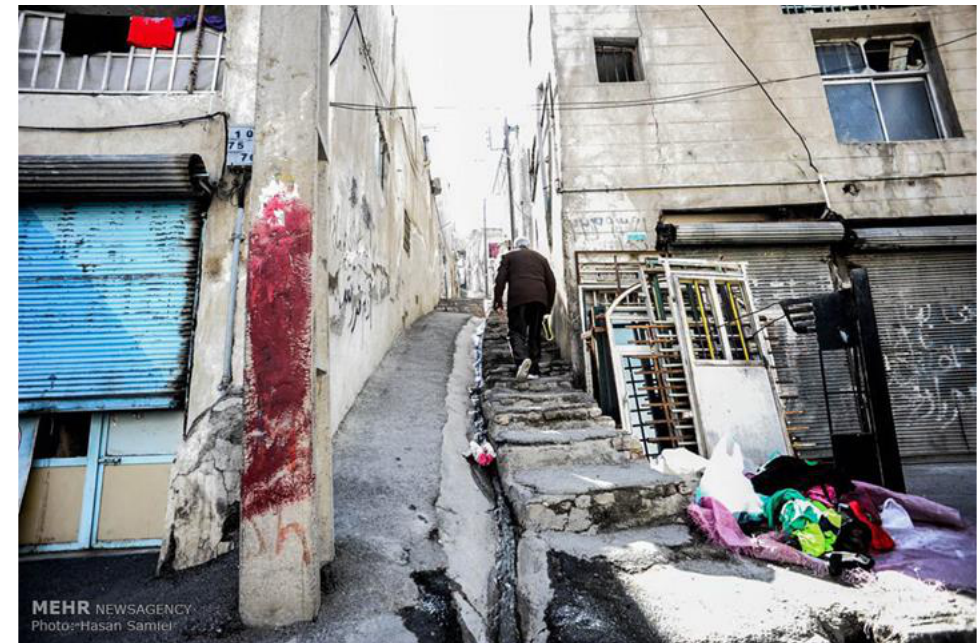
Fig. 5: Karaj, View of Zurabad Neighborhood (Mehrnews, 2015